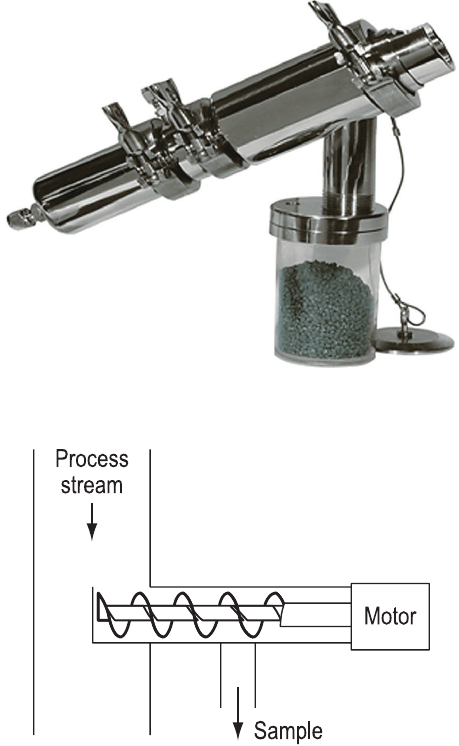
Fig. 5 Screw Sampler. (Courtesy of Sentry Equipment, www. sentry-equip.com)